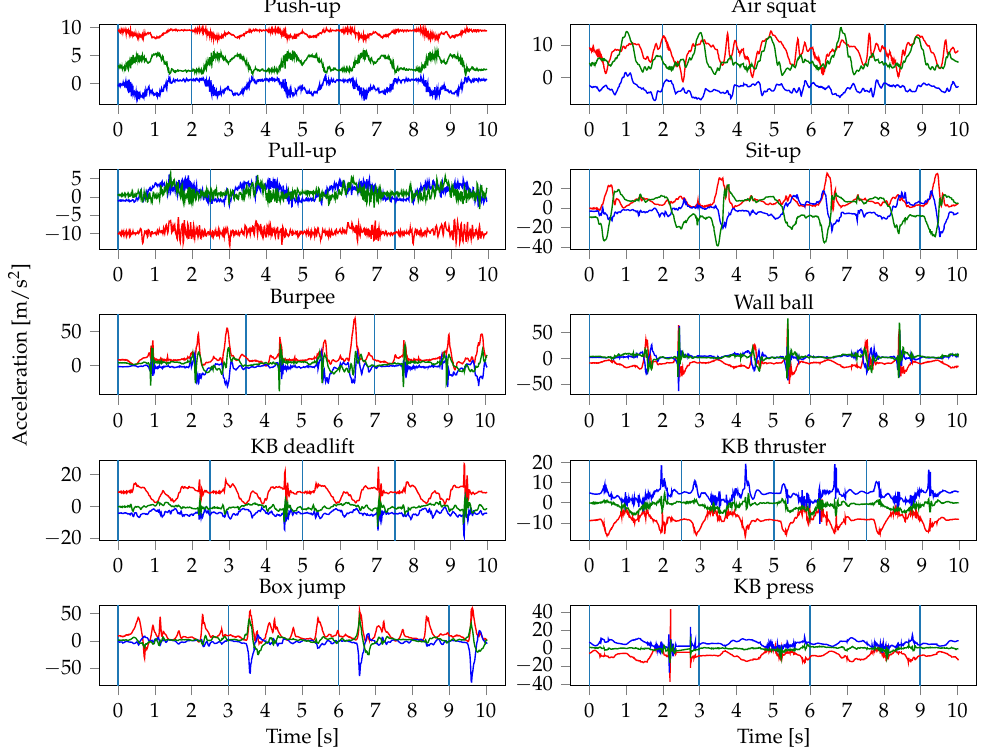
Figure A1. Accelerometer raw readings for 10 s for all exercises.